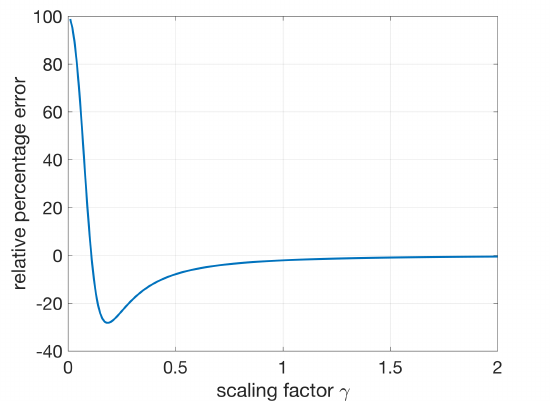
Figure 4. Coil resistances, equivalent load and total impedance of the starting system versus scaling factor.